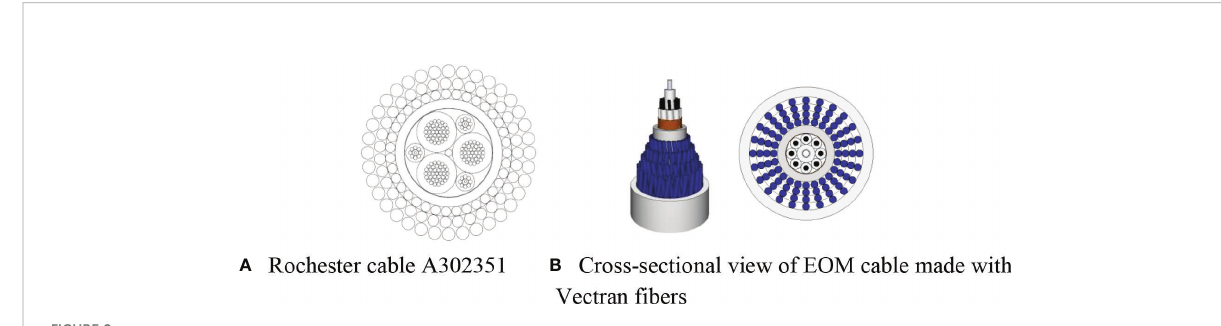
FIGURE 2 Design of mooring EOM cable. (A) Rochester cable A302351 (B) Cross-sectional view of EOM cable made with Vectran fi